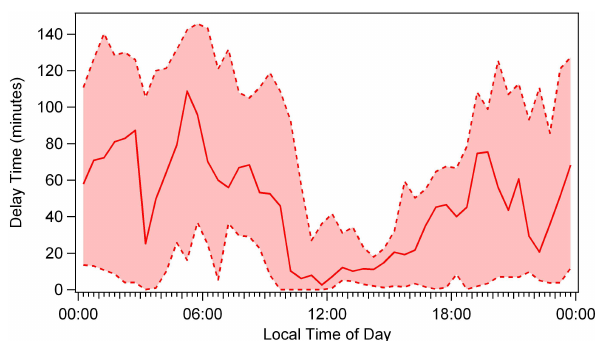
Fig. 10. Diurnal variation in delay time calculated from the cor- relation between above canopy and trunk space submicron particle measurements. Solid lines represent the median values, while the dashed lines and shaded area show the inter-quartile